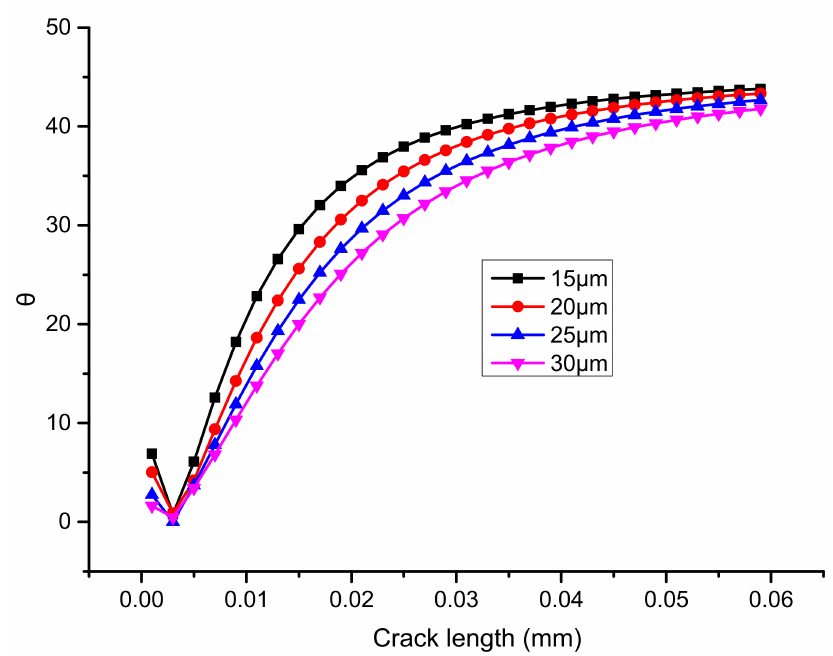
Figure 13. Relationship between the crack deflection angle and the main crack length under different solder